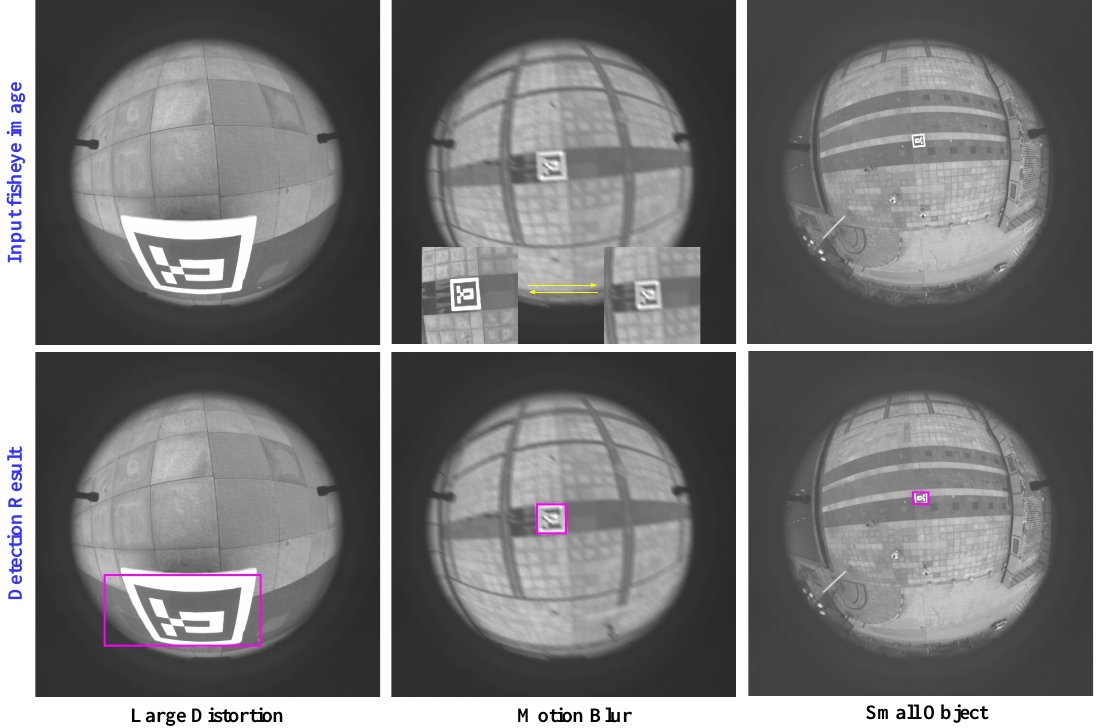
Figure 4. Target detection results in some challenging scenarios. The top and bottom rows represent the input image and detection results, respectively, under a large distortion, motion blur conditions, and small object